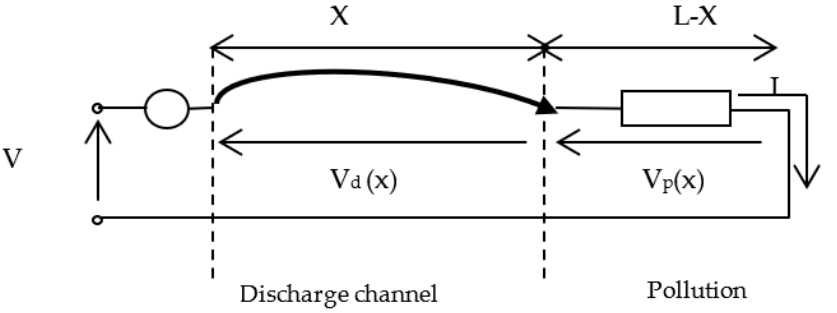
Figure 1. Equivalent electrical circuit based on Obenaus model. V : applied voltage, V d ( X ): discharge voltage, V p ( X ): pollution voltage, I : leakage current, X : discharge length, L - X : nonshunted insulator creepage length.